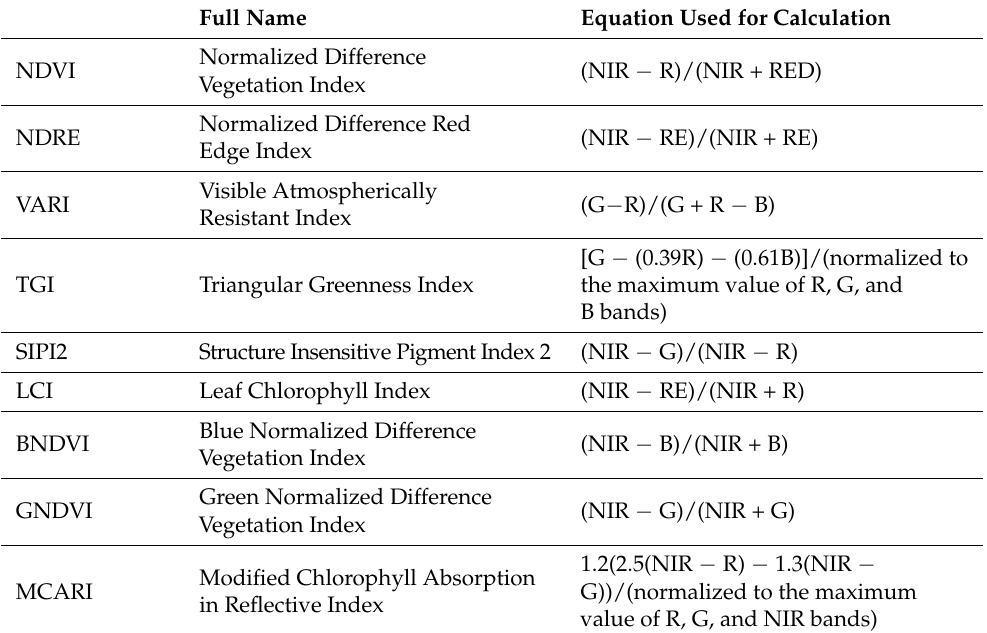
Table 3. Vegetation indices used in the